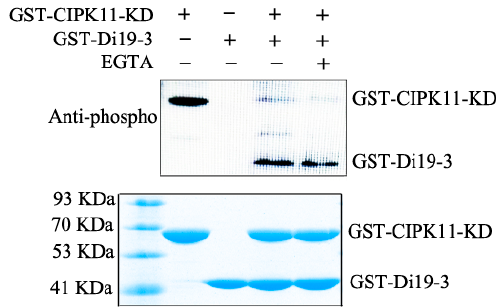
Figure 4. Phosphorylation of Di19-3 by CIPK11 in vitro. In vitro phosphorylation assay of Di19-3 was detected by immunoblotting with an anti-phosphothreonine antibody. The loading amounts of proteins were visualized with the Coomassie Brilliant Blue (CBB) stained gel (bottom panel). The experiment was conducted with at least three biological replicates.